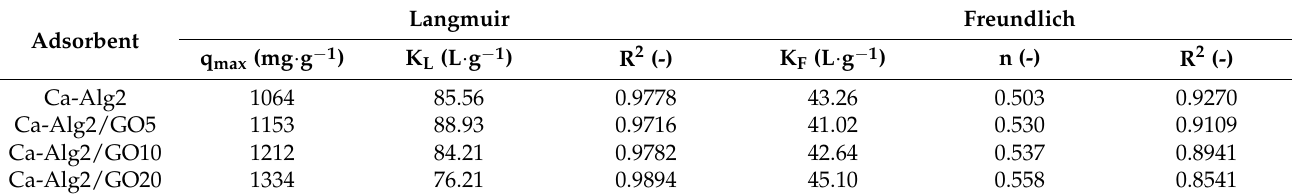
Table 8. Langmuir and Freundlich isotherm constants for FMTD adsorption onto Ca-Alg2 and Ca-Alg2/GO beads. Adsorbent